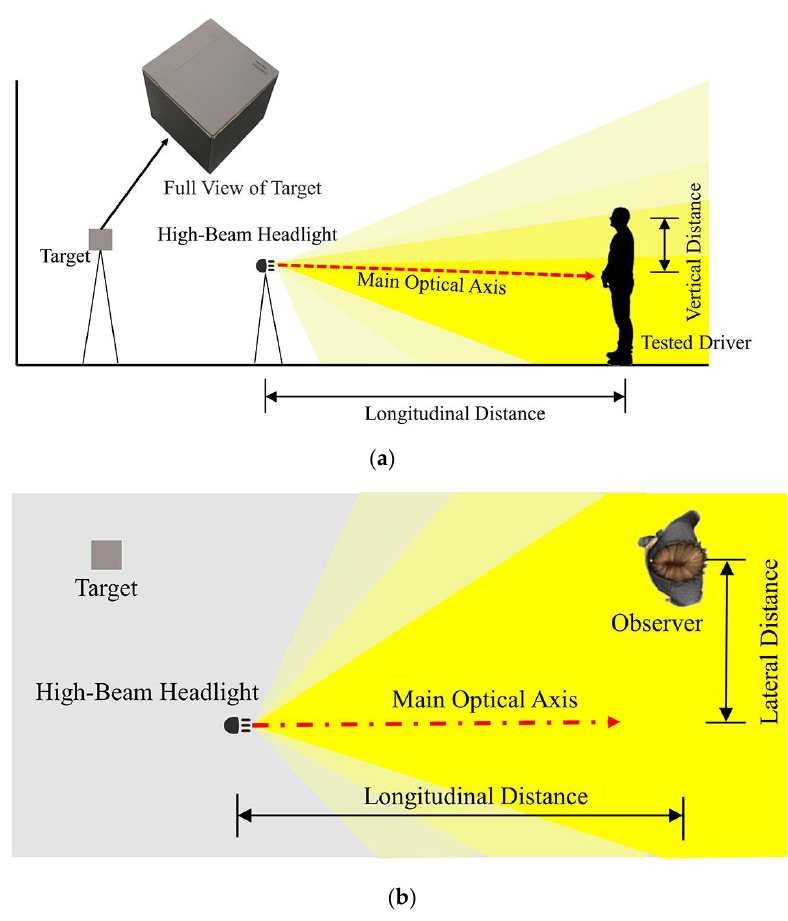
Figure 2. Diagram of the glare effect tests. ( a ) Side view, ( b ) Vertical view.